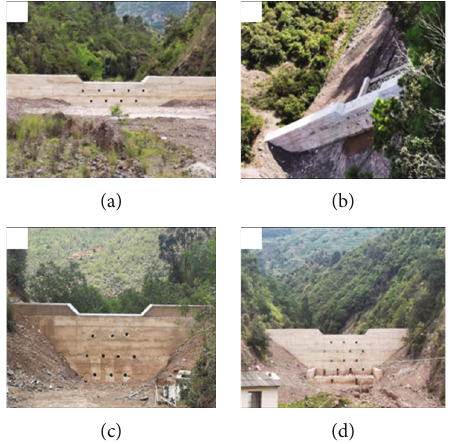
Figure 19: Current situation of